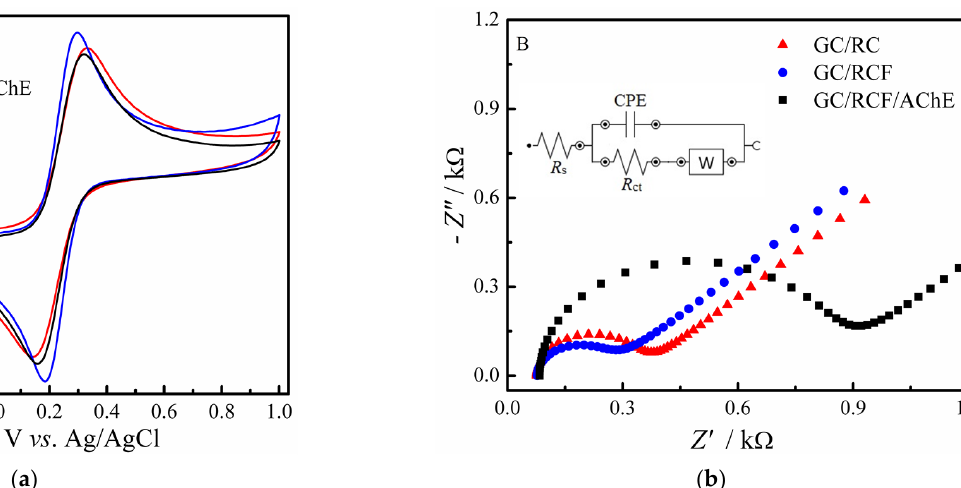
Figure 3. Electrochemical characterization of the electrodes in a 0.2 mol L − 1 PBS (pH 7.4) solution